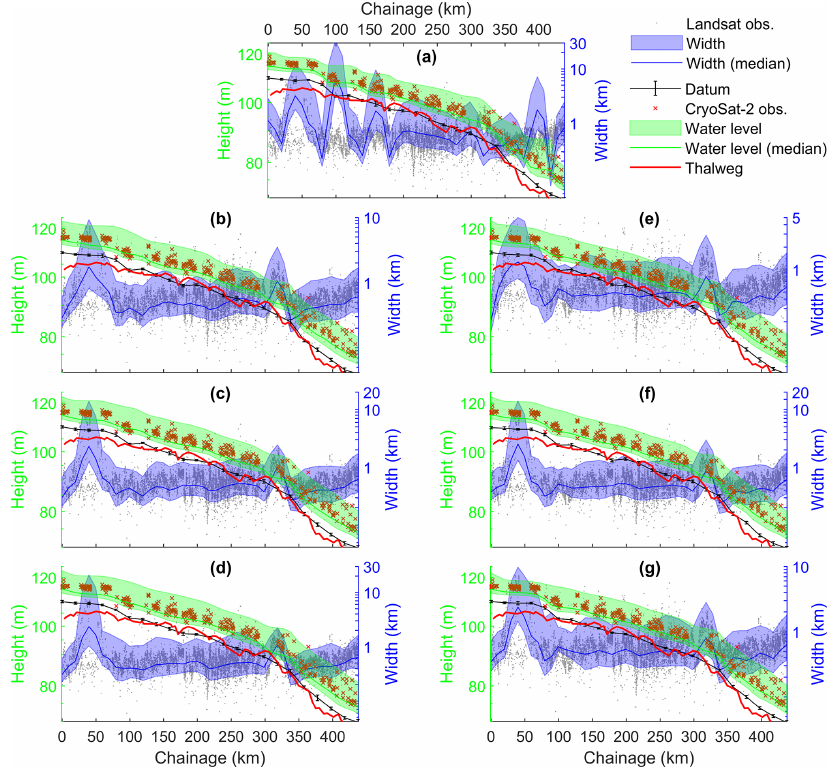
Figure C2. Comparison of model simulated water level, width, and datum using different calibration data sets. (a) Calibration #1; (b) cali- bration #2a; (c) calibration #2b; (d) calibration #2; (e) calibration #3a; (f) calibration #3b, and (g) calibration #3. Note that y axes are in log scale. Color bands indicate the boundary (i.e., maximum and minimum) of simulations. Along with model simulations, satellite observations of WSE and width are